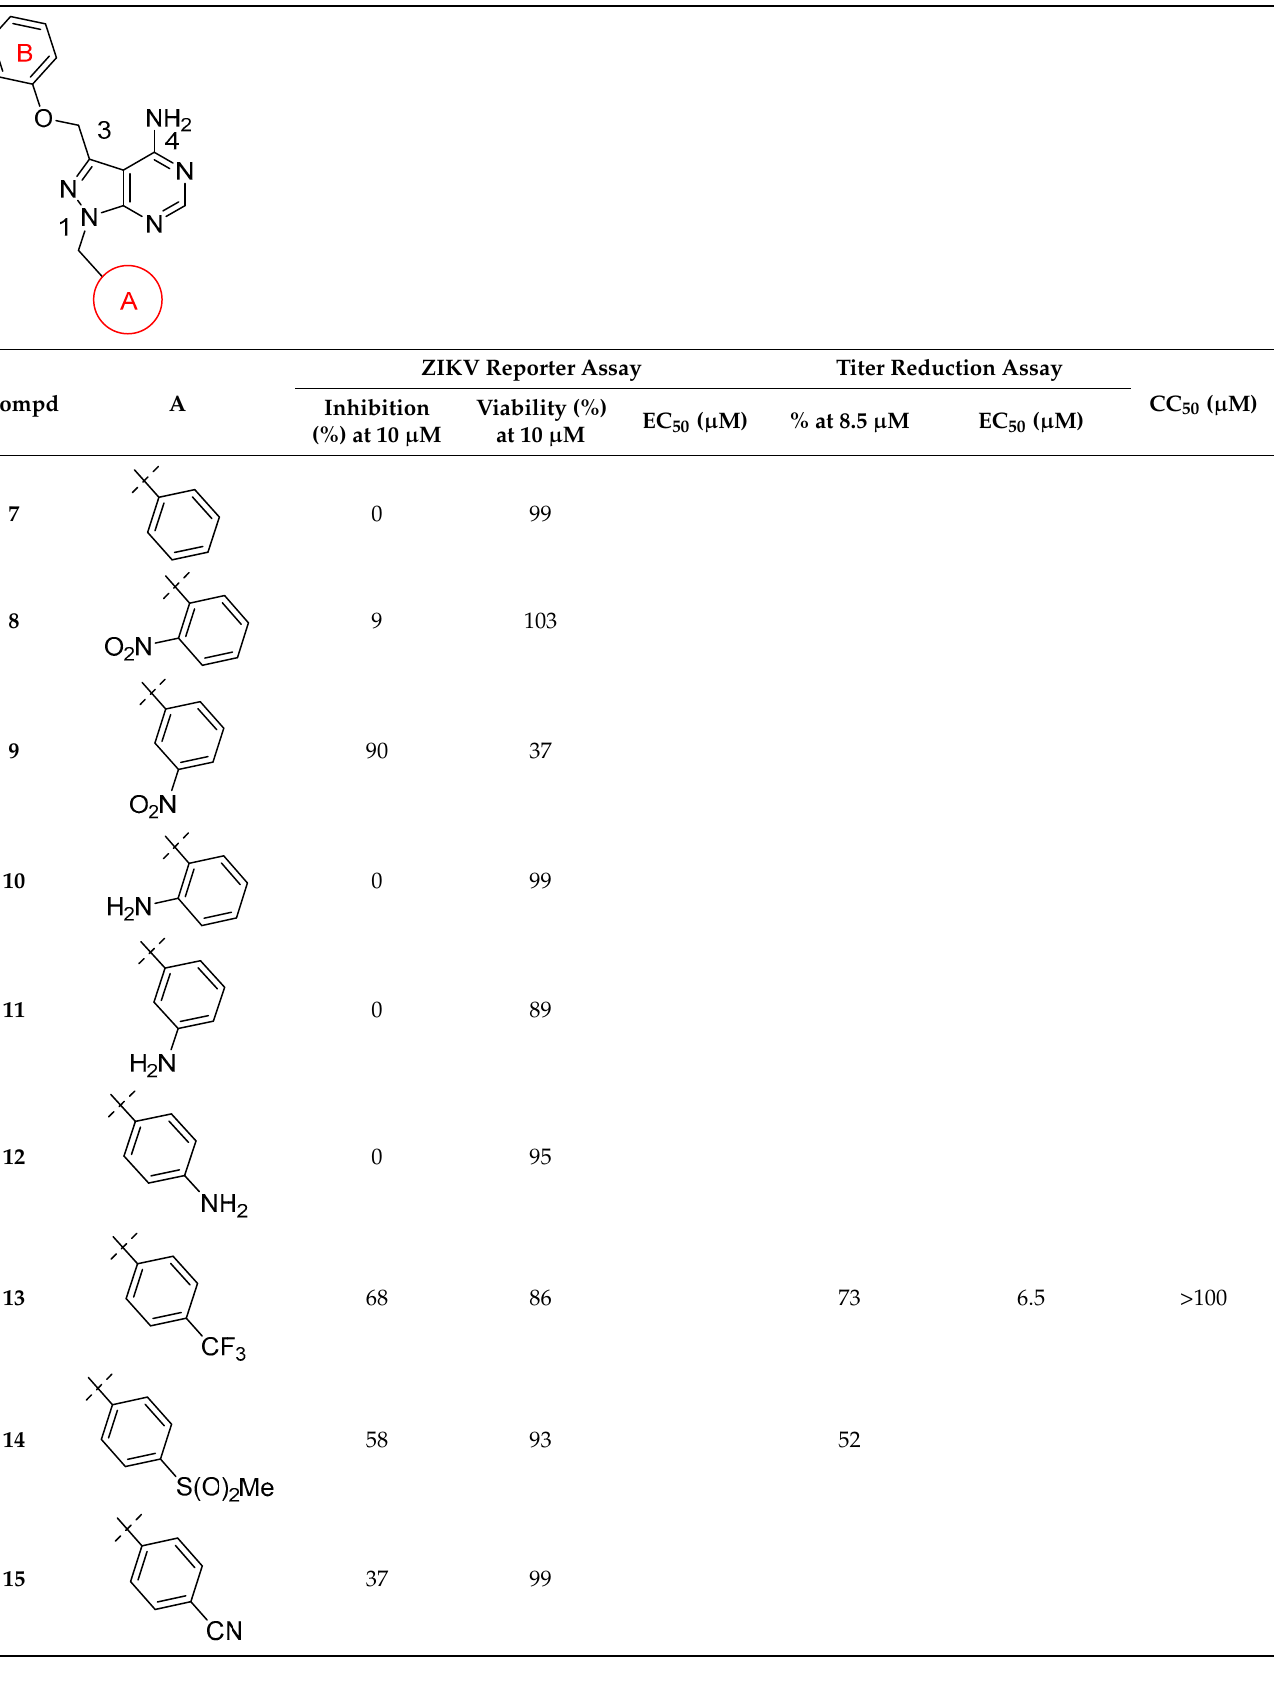
Table 2. Cont. Table 2. SAR study on ring A of 1 H ‐ pyrazolo[3,4 ‐ d]pyrimidin ‐ 4 ‐ amine